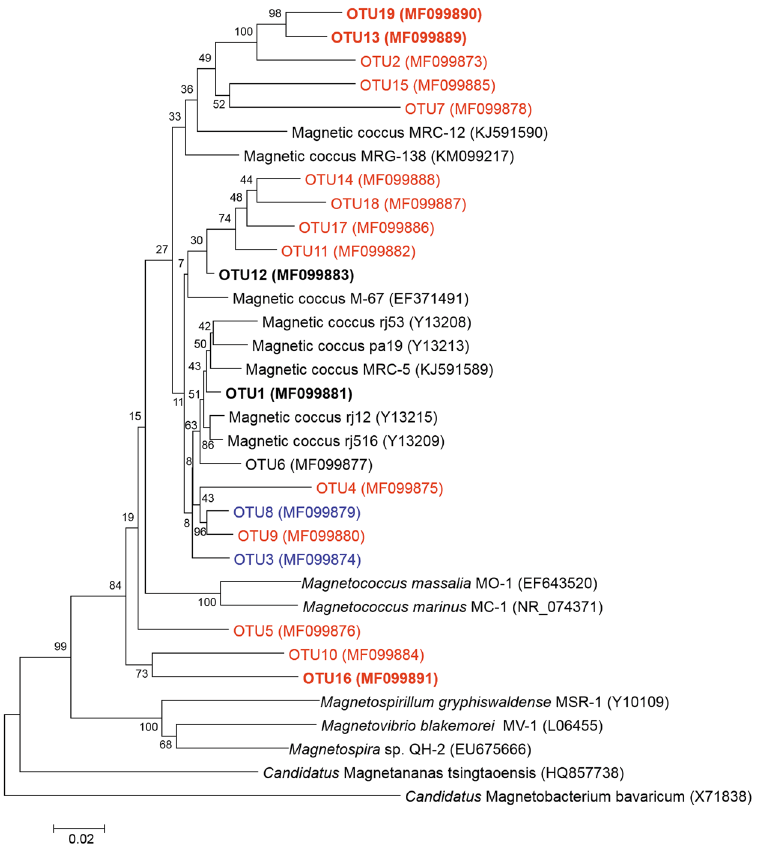
Figure 5. Phylogenetic tree based on 16S rRNA gene sequences for the 19 MTB OTUs identified from live MTB samples. The phylogenetic tree was constructed based on neighbor-joining analysis. Bootstrap values at the nodes are percentages of 1,000 replicates. We used 97% and 95% sequence identity as the thresholds for classifying to species and genus levels, respectively. OTUs belonging to new species are indicated in blue. OTUs belonging to new genera are indicated in red. OTUs identified from micromanipulated samples are emphasized in bold characters. The scale bar indicates 2% sequence